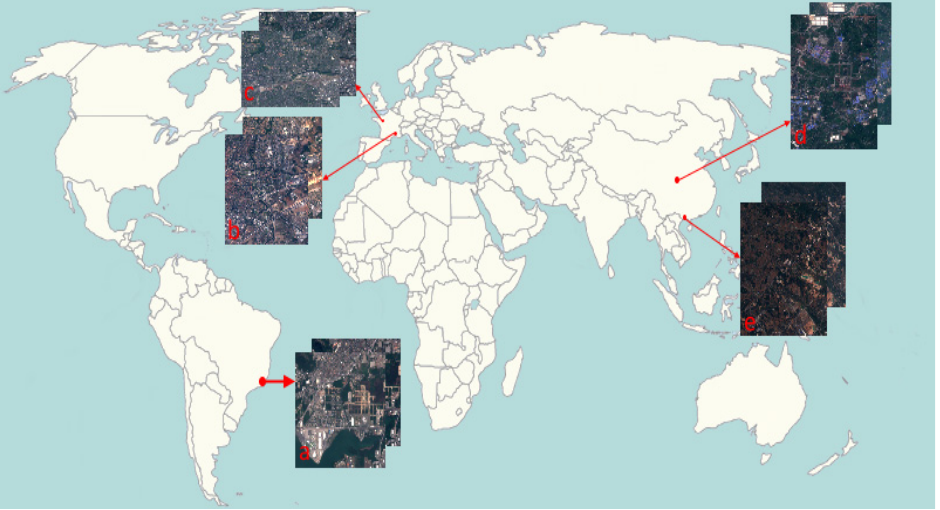
Figure 2. Multi-temporal image datasets. ( a ) Rio, ( b ) Montpellier, ( c ) Rennes, ( d ) Chongqing, and ( e ) Beihai. Table 3. Information on datasets used in this study.